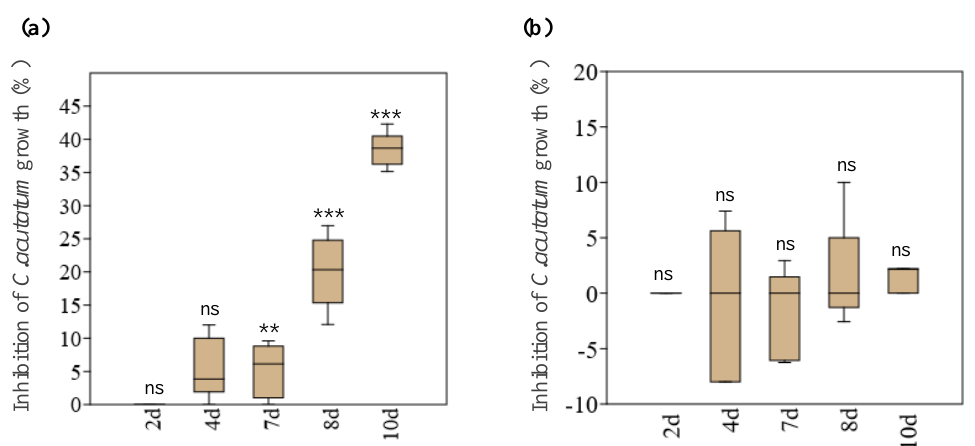
Figure 1. Inhibition (%) of Colletotrichum acutatum growth by the endophytes Aureobasidium pullulans ( a ) and Sarocladium summerbellii ( b ), after 2, 4, 7, 8 and 10 days of interaction. Box plots depict medians (central horizontal lines), inter-quartile ranges (boxes) and 95% confidence intervals (whiskers). Asterisks indicate statistical significance compared with the control ( n = 5), at *** p < 0.001 and ** p < 0.01, within each day of interaction. ns: not significant.